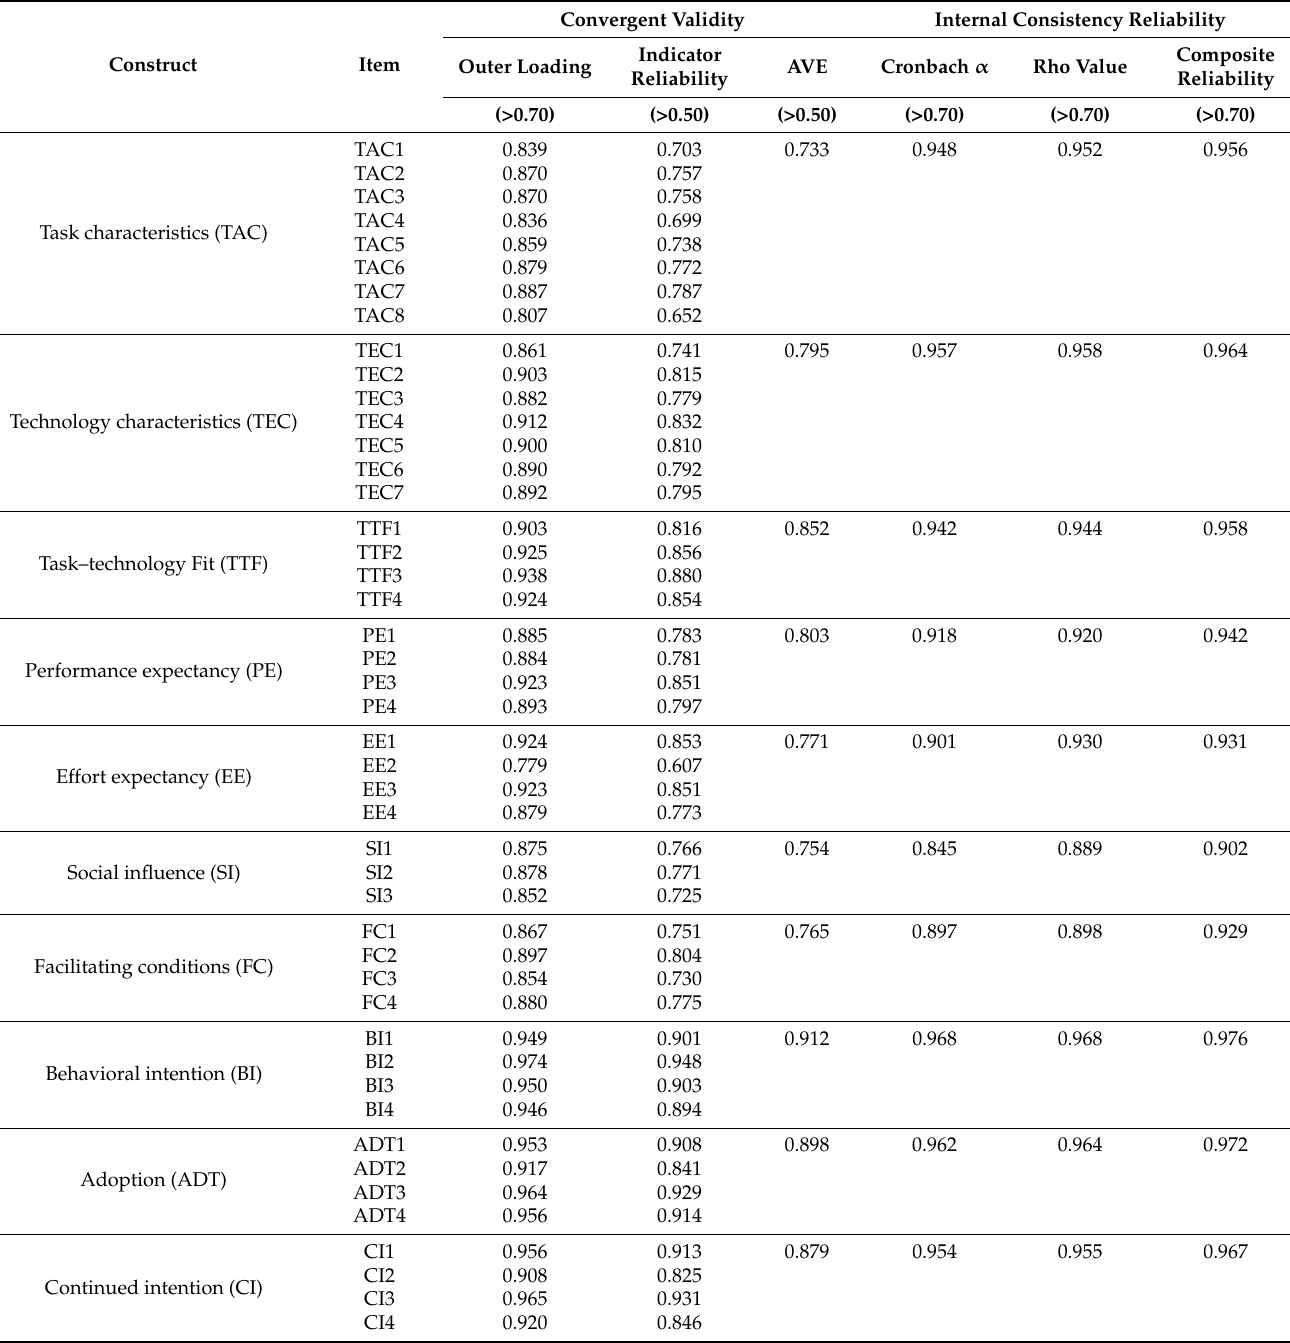
Table 5. The measurement model